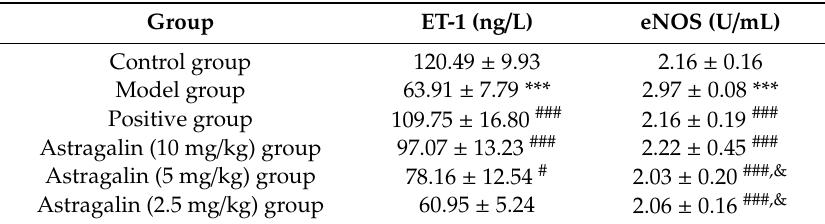
Table 7. Effects of astragalin on ET-1 and eNOS (X ± SD, n = 8). Table 7. E ff ects of astragalin on ET-1 and eNOS (X ± SD, n = 8).